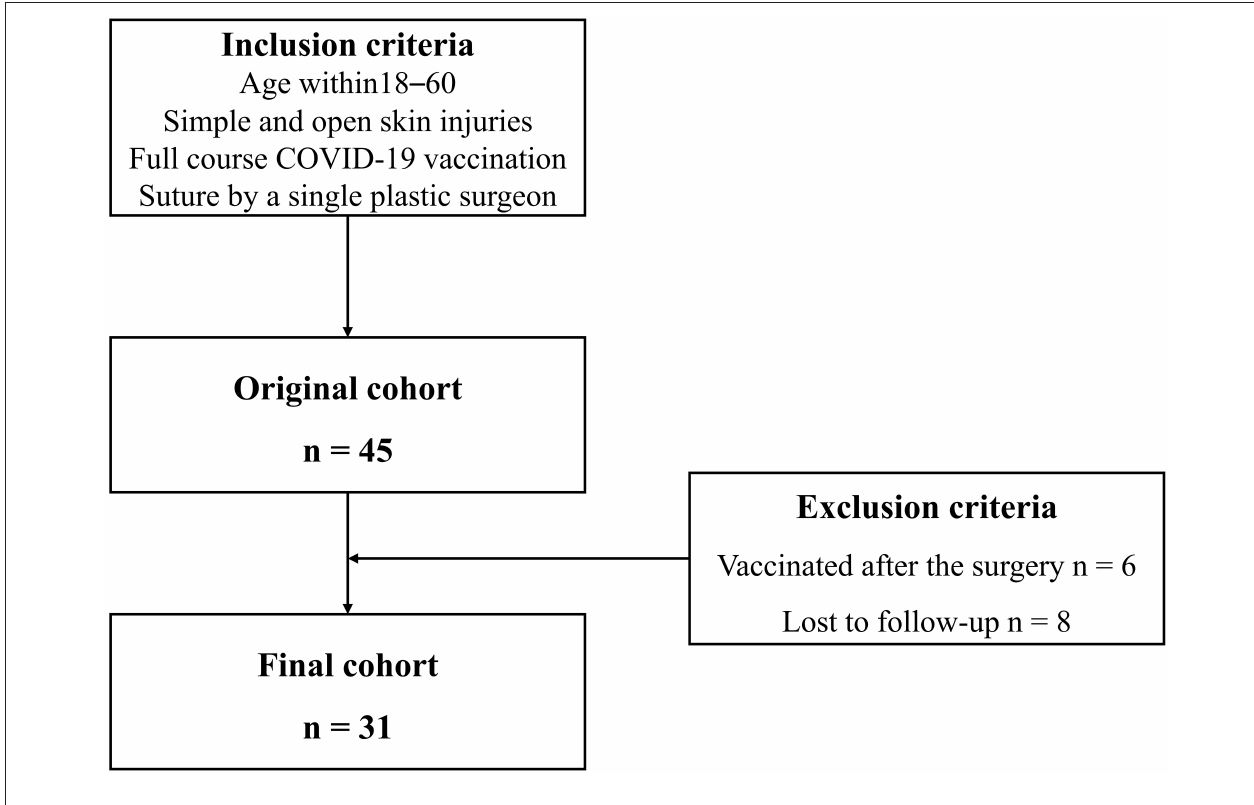
FIGURE 1 | Flow diagram of this